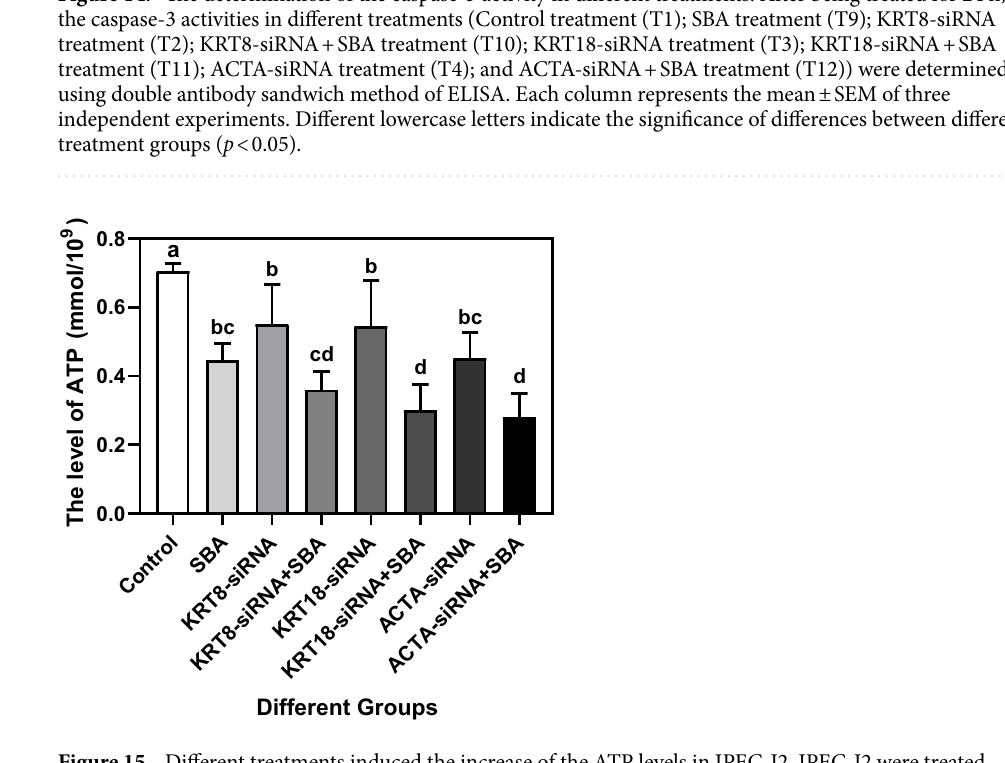
Figure 15. Different treatments induced the increase of the ATP levels in IPEC-J2. IPEC-J2 were treated in different treatments (Control treatment (T1); SBA treatment (T9); KRT8-siRNA treatment (T2); KRT8- siRNA + SBA treatment (T10); KRT18-siRNA treatment (T3); KRT18-siRNA + SBA treatment (T11); ACTA- siRNA treatment (T4); ACTA-siRNA + SBA treatment (T12)) for 24 h. ATP levels were detected using the ELISA method. Each column represents the mean ± SEM of three independent experiments. Different lowercase letters indicate the significance of differences between different treatment groups ( p <